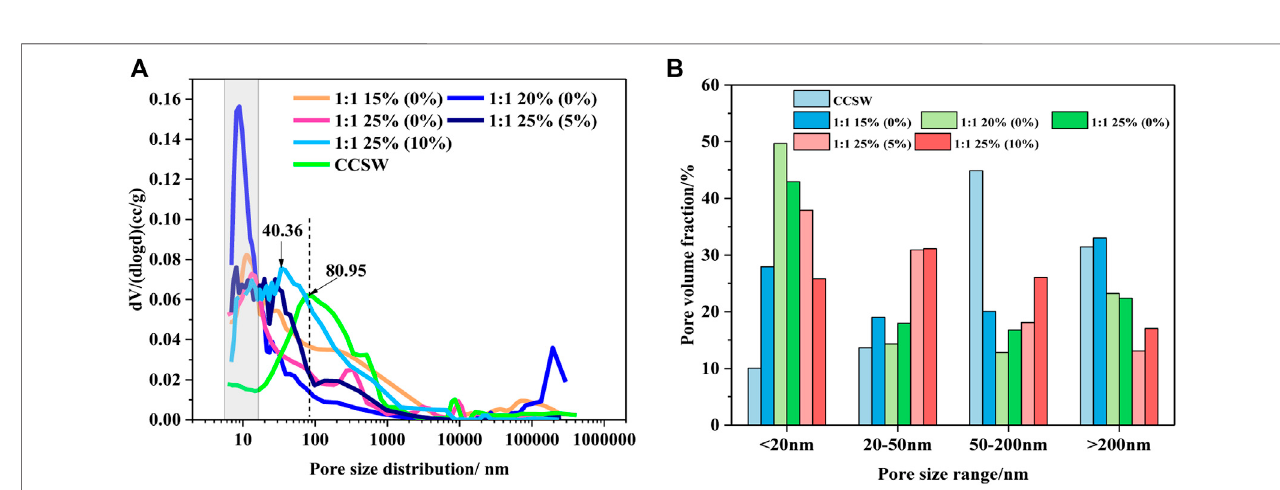
FIGURE 10 | Pore characteristics of CCSW and GCSW composites ( A : pore distribution, B : pore volume fraction).